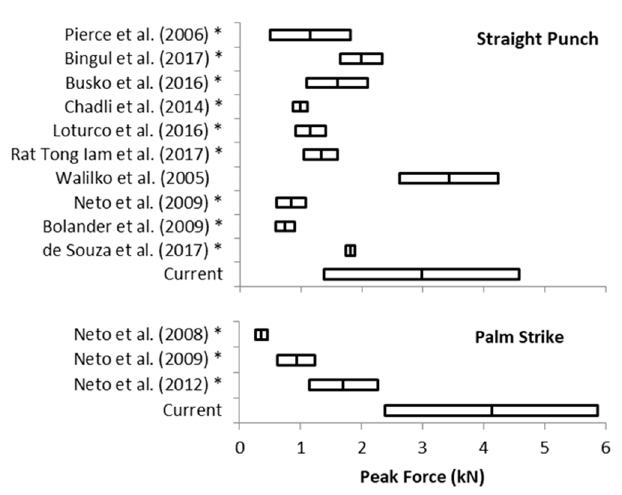
Figure 4. Comparison of straight punch and palm strike peak forces reported in previous studies. * significantly lower than current study. The bar present the means and standard deviations.